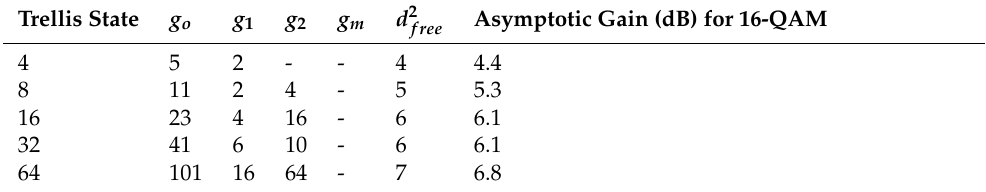
Table 1. Optimal polynomial generators for a good TCM